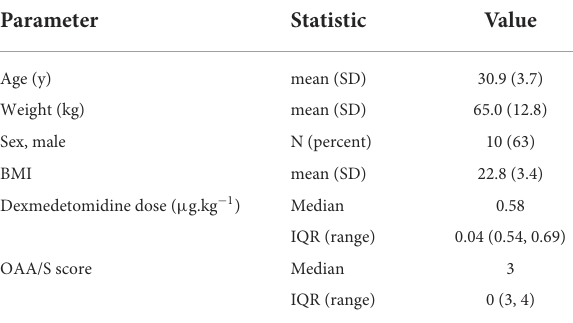
TABLE 1 Demographic data of participants ( n = 16).